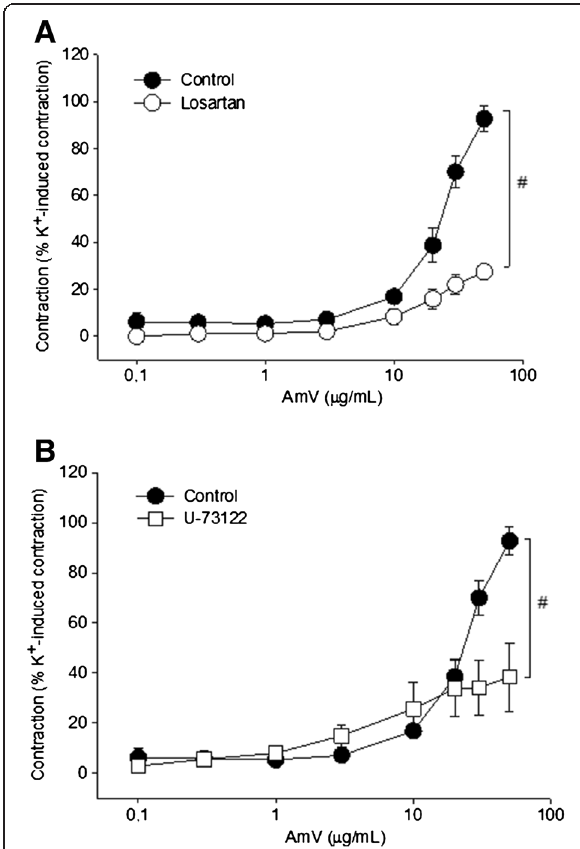
Figure 4 Study on the probable action mode of AmV. Vasoconstrictor effects of AmV: (A) pretreatment with losartan (100 μ M; Ο , n = 5); (B) pretreatment with U-73122 (10 μ M; □ , n = 5). Vasoconstrictor effects are expressed as a percentage of the contractile response to K + (60 mM). Data are expressed as mean ± SEM and analyzed by ANOVA followed by the Holm-Sidak